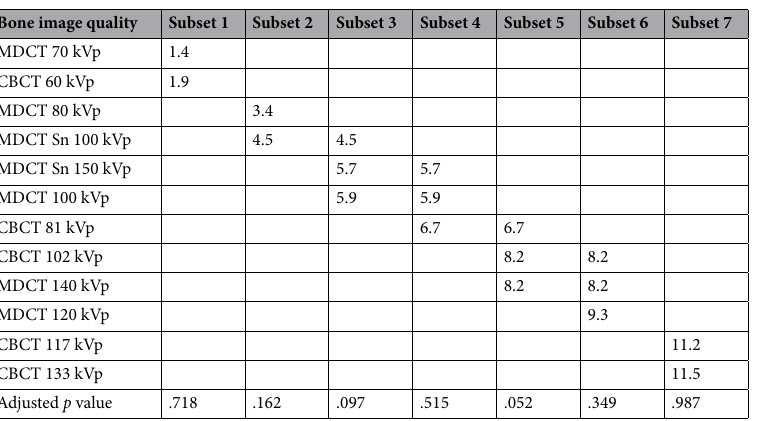
Table 4. Homogeneous subset analysis for bone image quality based on tube voltage groups. After differences between dependent nonparametric variables were ascertained with the Friedman test ( p < .001), groups were compared pairwise with post-hoc tests and listed in order of ascending mean rank. The rank means that are listed under each subset are not significantly different from each other. In contrast, mean values that are not listed in the same subset differ significantly (adjusted p value for multiple comparisons < .050).